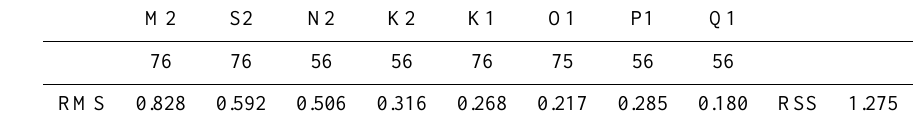
Fig.3. RepresentersanddatasitesusedforthecomputationofMEDI10